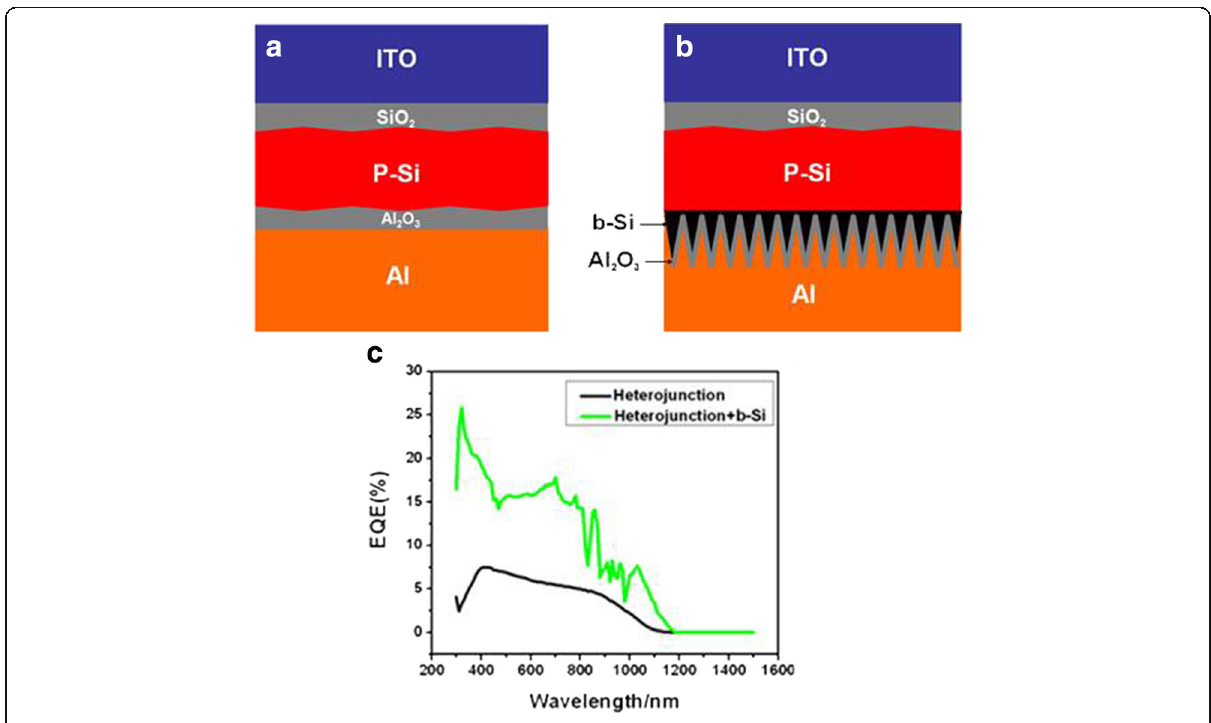
Fig. 6 Schematics of a heterojunction structured PV device without ( a ) and with ( b ) b-Si at the rear and their EQE curves ( c